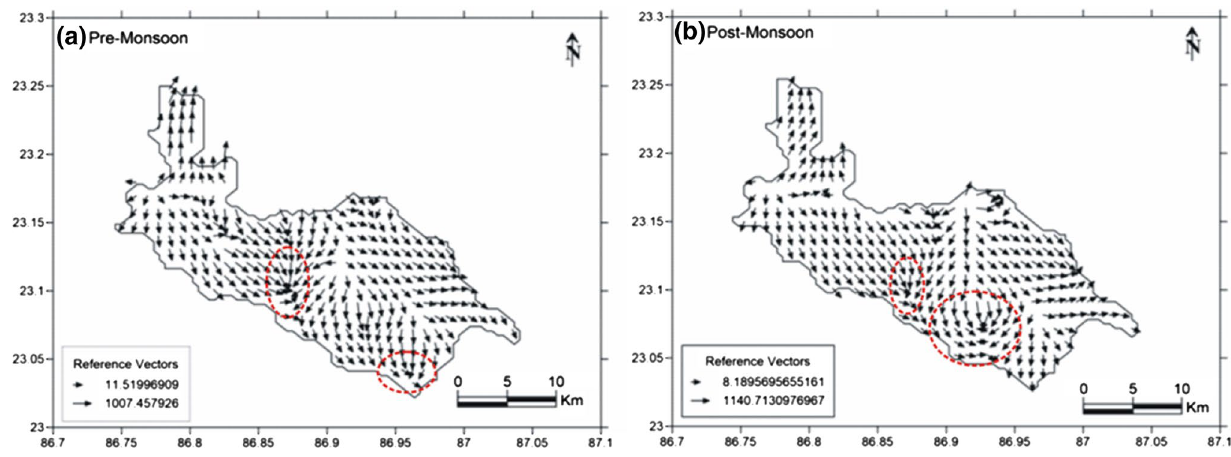
Fig. 4 Vector plot showing groundwater flow directions and shift of recharge zones during a PrM; b